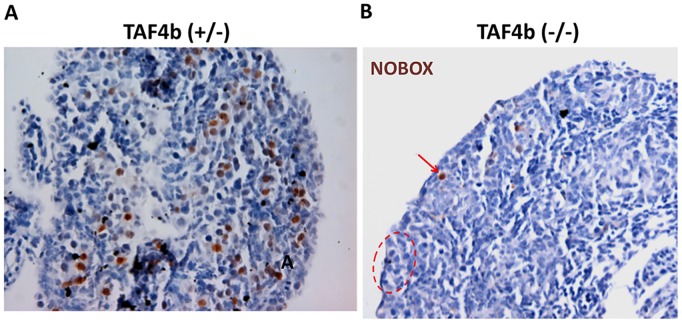
Reduced NOBOX protein expression in Taf4b-deficient ovaries.(A) Immunohistochemistry detecting NOBOX protein was performed on E18.5 Taf4b-heterozygous and (B) Taf4b–deficient ovary tissue sections. While some Taf4b-deficient oocytes still express high levels of NOBOX (red arrow), many germ cells possess little to no NOBOX expression (dashed red circle).